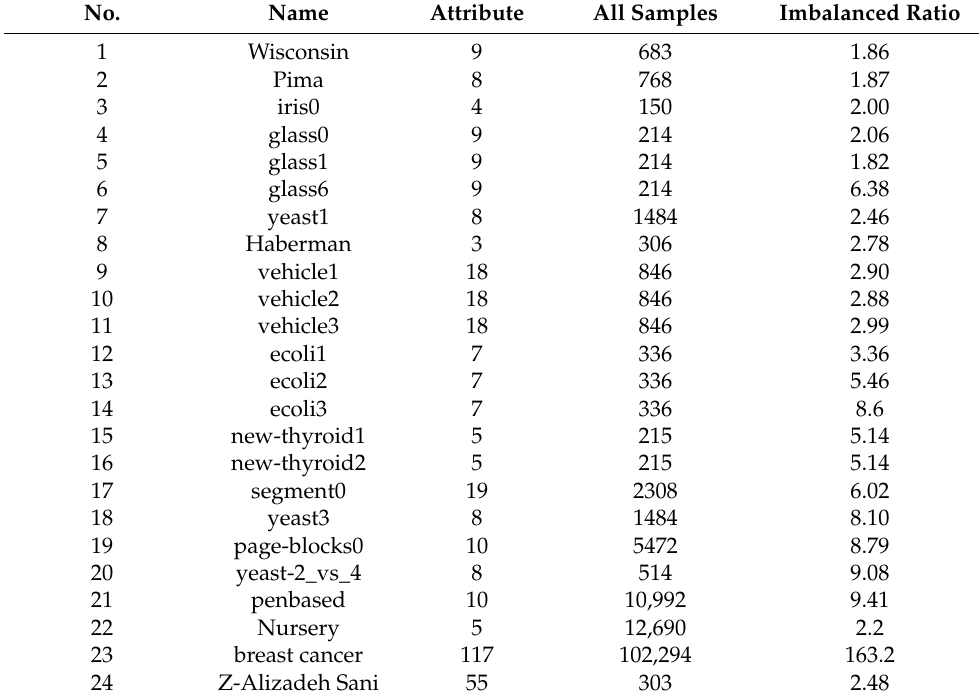
Table 5. Datasets description in